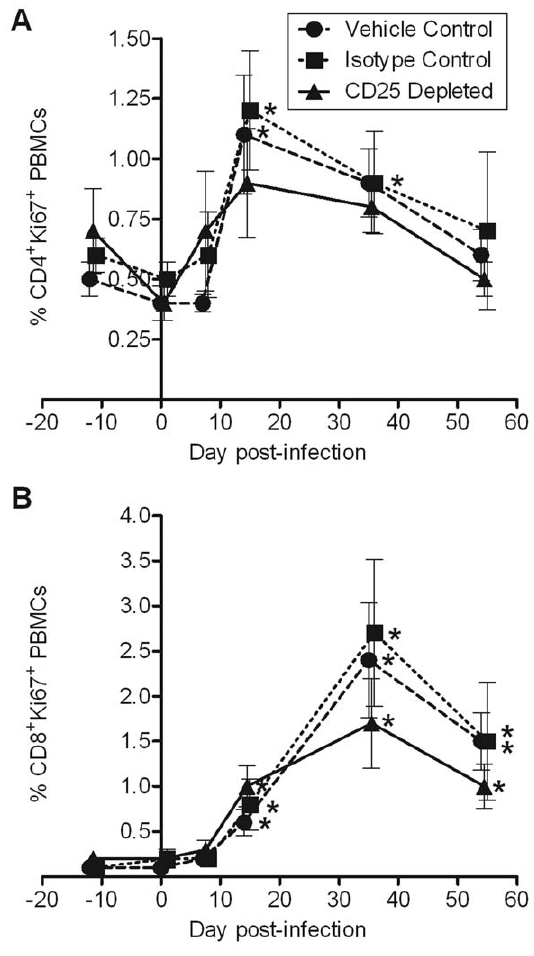
Figure 5. T cell proliferation due to FIV infection is not enhanced by anti-CD25 mAb treatment. Percent (A) CD4 + Ki67 + T cells and (B) CD8 + Ki67 + T cells in circulation were quantified by flow cytometry on days 2 12, 0, 7, 14, 35, and 54 p.i. (n=8/group). Mean 6 SEM is shown. Significance is relative to day 0 values for each group. No significant differences were found between treatment groups. * indicates p , 0.05.